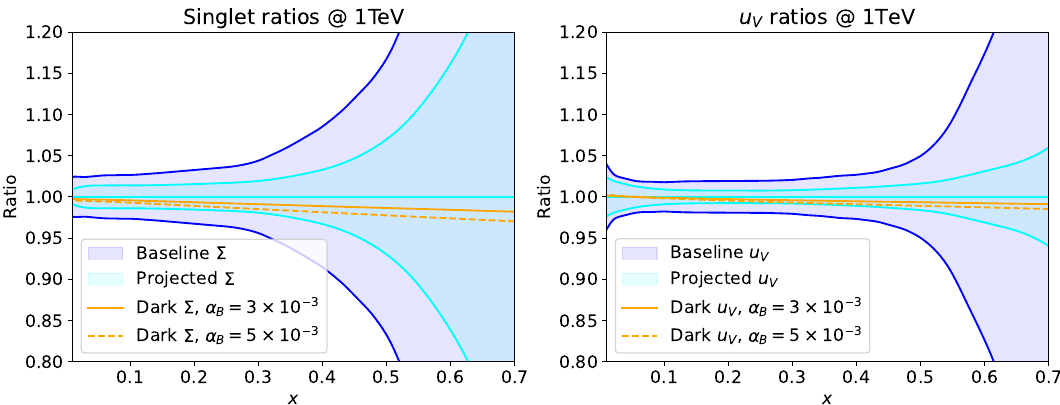
Figure 3 . In solid orange, the ratio between the central singlet PDF Σ (left) and central u -valence PDF (right), drawn from the dark benchmark scenario in eq. (2.6), to the baseline SM central replica at Q = 1 TeV. In dashed orange, the same ratios but between the SM baseline and a dark PDF set produced using m = 50 GeV , α = 5 × 10 − 3 . In each case, the uncertainty bands represent the B B 68% C.L. PDF uncertainties of the baseline set (in blue) and the projected PDF uncertainties at the HL-LHC, determined from ref. [43] (in light blue). The deviation when α = 5 × 10 − 3 approaches B the boundary of the projected HL-LHC uncertainty bands, consistent with the behaviour we see in figure 5 later; increasing α (and also to a milder extent, decreasing m ) pushes the deviation B B outside of projected HL-LHC uncertainty bands. See the main text for more